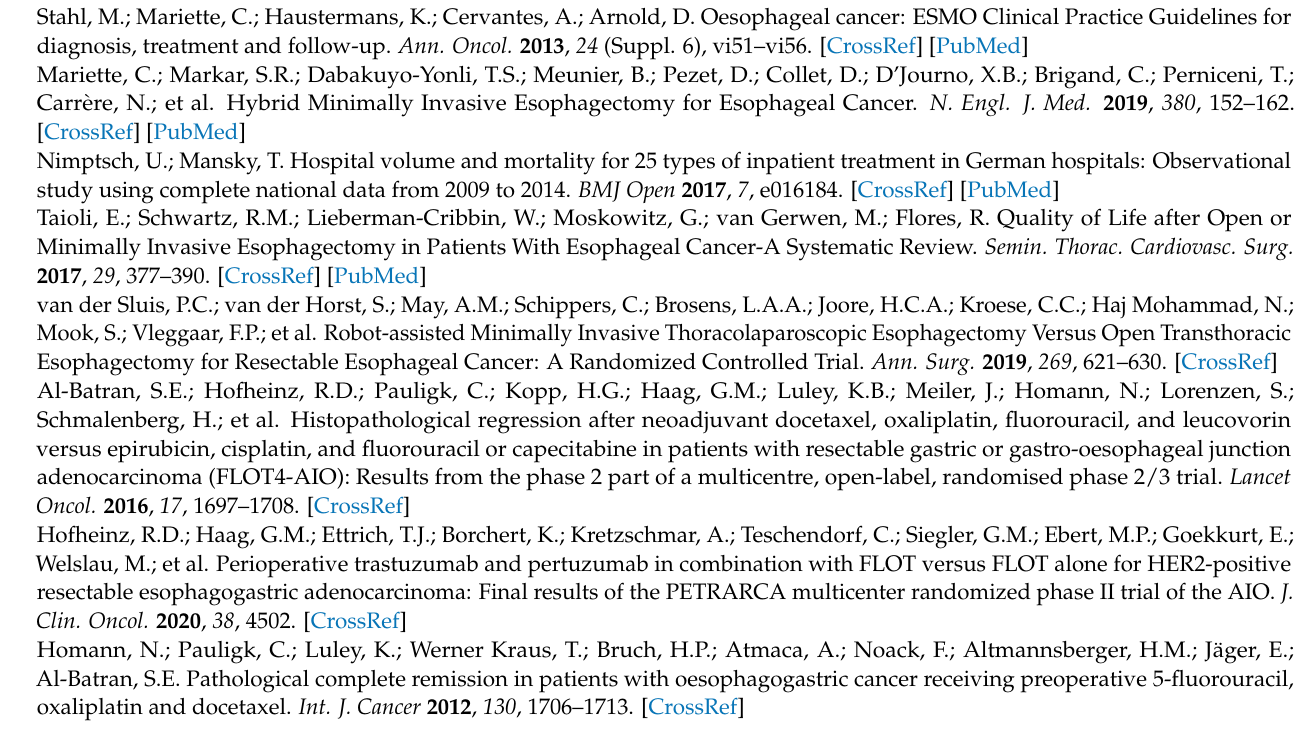
Library, Table S3: Search strategy for Web of Science, Table S4: Search strategy for ScienceDirect